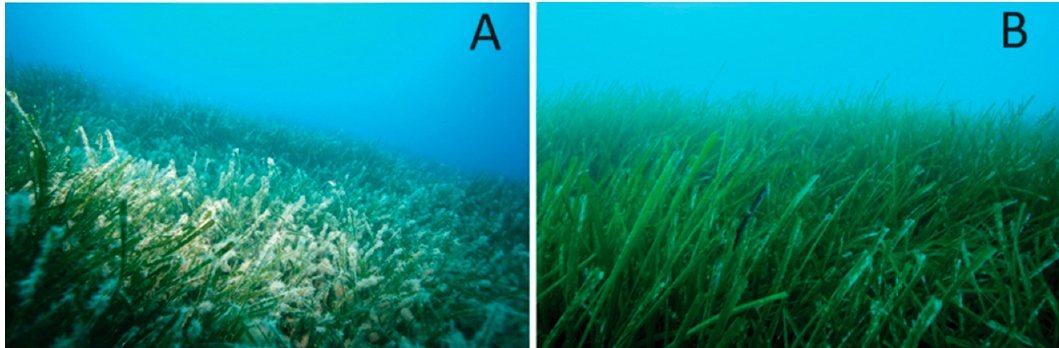
Figure 2. ( A ): Station 4 at 15 m near a fish farm, P. oceanica covered with epiphytes. ( B ): Station 8 at 15